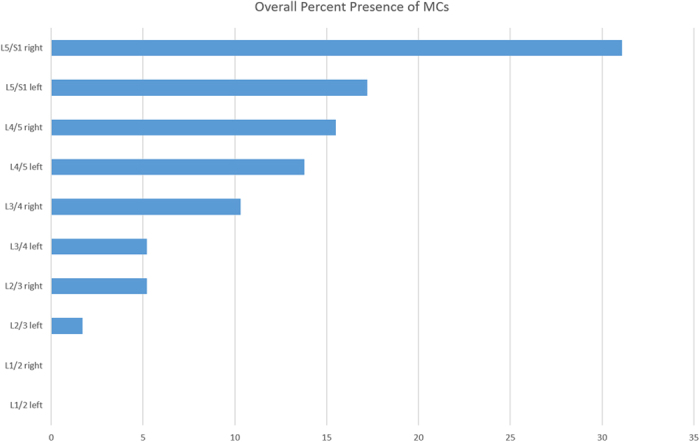
The overall prevalences of MCs according to lumbar disc level in both sides.